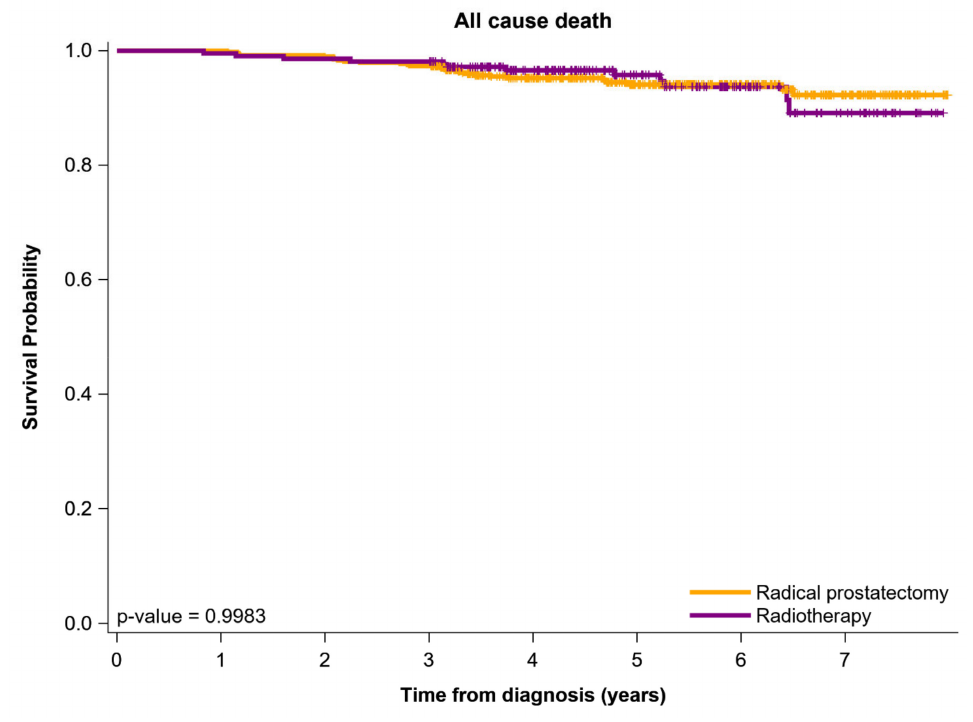
Figure 1. Survival curves for endpoints by Kaplan–Meier method for propensity score-matched young patients with NCCN high- to very high-risk prostate adenocarcinoma receiving various curative-intent treatments NCCN, National Comprehensive Cancer